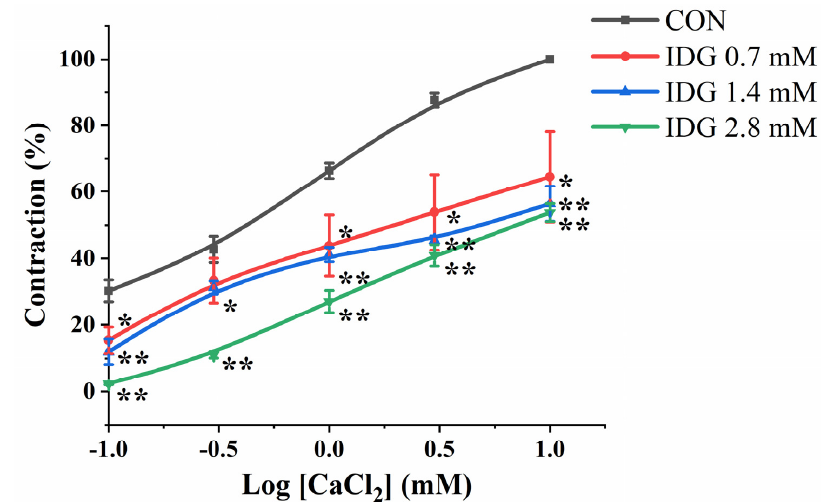
Figure 5. CaCl 2 -induced contractions of endothelium-denuded aortic rings pre-incubated in high K